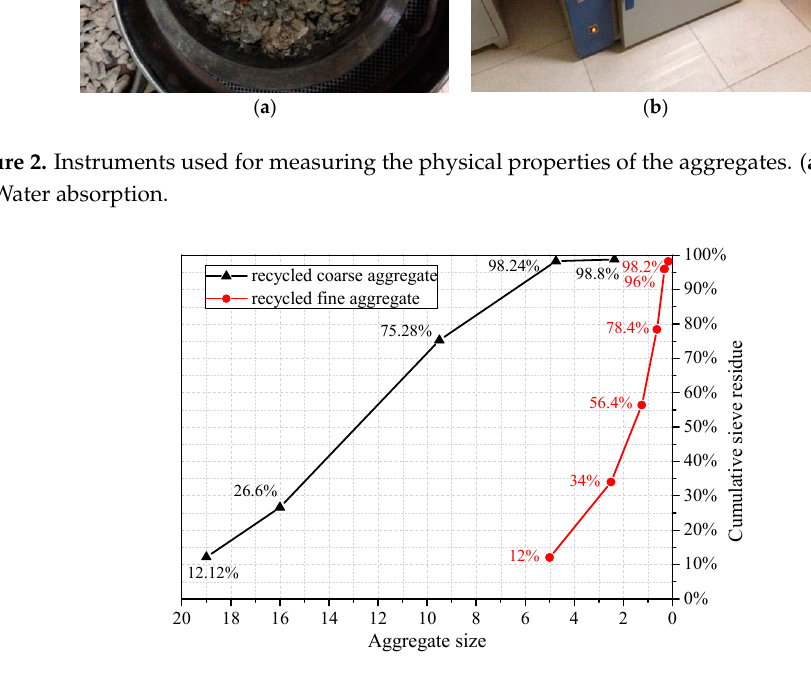
Figure 3. Particle size distribution of recycled coarse and fine aggregates.